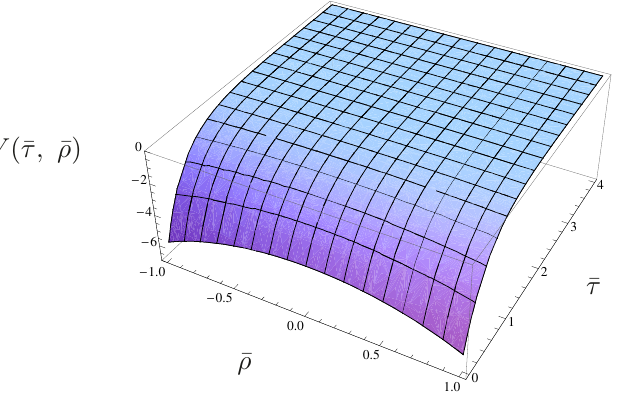
Figure 7 . The moduli potential V (¯ τ, ¯ ρ ) in the type IIB theory for the case of R (Y) = 0, A H = A p = A D p = 0, and A O p d p − 3 x √ g p − 3 = 1 , ( p = 3 , 5 , 7 , 9), and κ = 1 is shown in the (¯ τ, ¯ ρ ) space. R